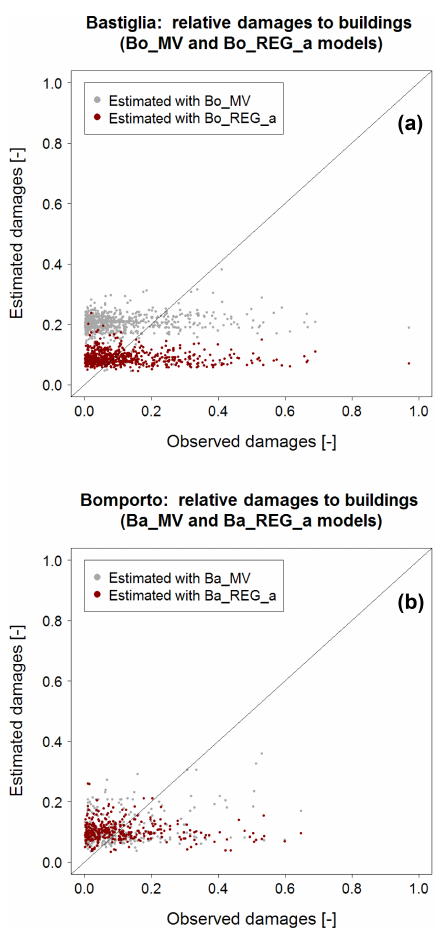
Figure C2. (a) Bastiglia relative damages to buildings estimated with Bo_REG a (red dots) and Bo_MV (grey dots); (b) Bomporto relative damages to buildings estimated with Ba_REG a (red dots) and Ba_MV (grey